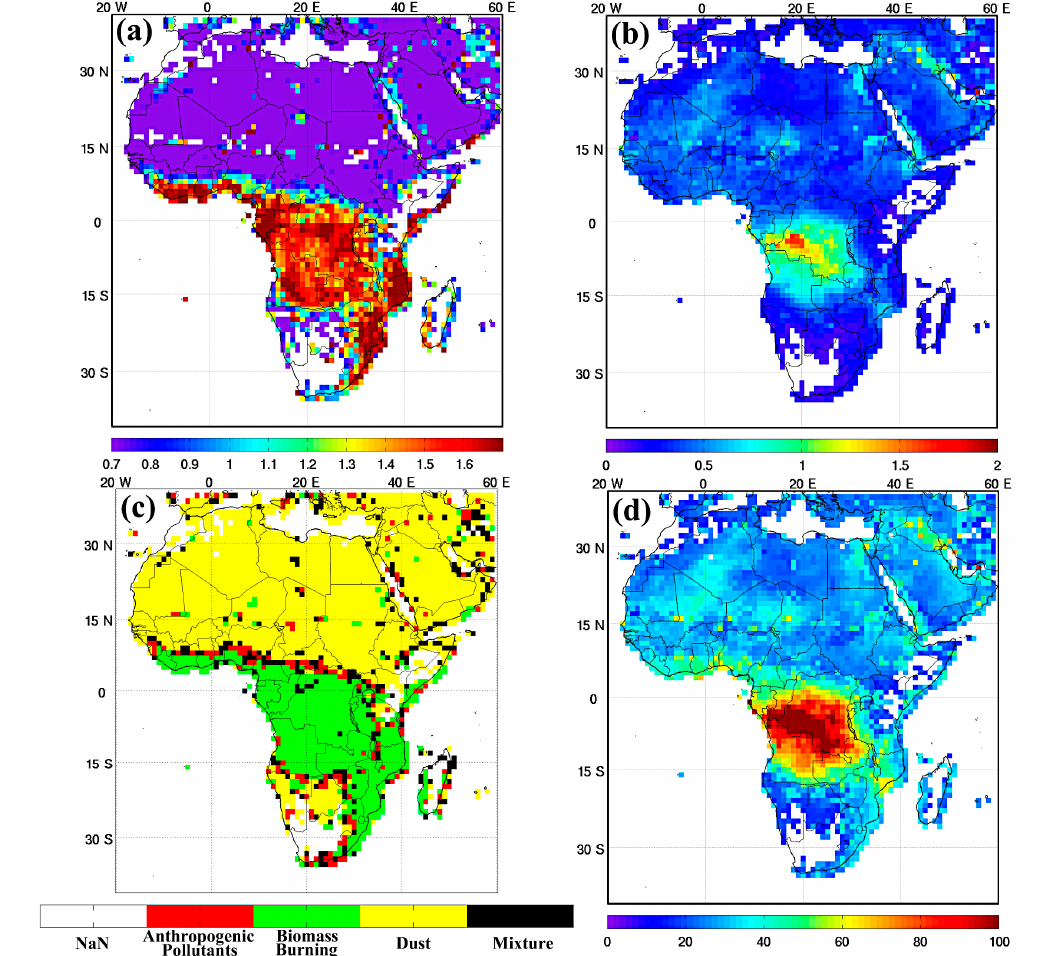
Figure 1. Illustration the MODIS monthly products of ( a ) AOD 660nm and ( b ) AE 470_660nm in September 2015 (1° × 1°), and ( c ) the spatial distribution of aerosol types including biomass (green), anthropogenic (red), dust (yellow) and mixture (black) and ( d ) the PM 2.5 concentrations ( μ g/m 3 ).